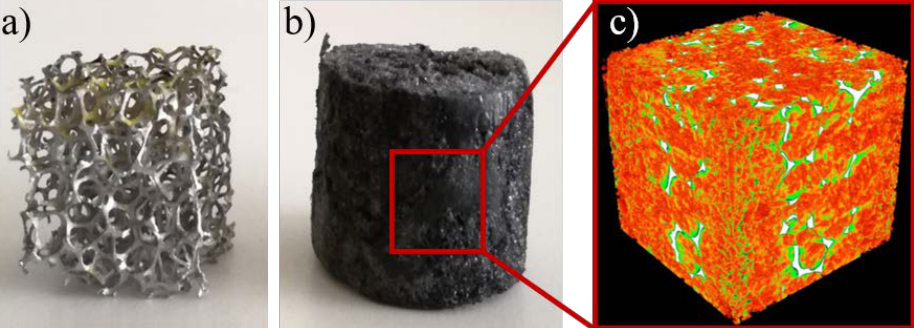
Figure 5. Specimens ( a ) Al-OC; ( b ) PUF/GNPs2.5-OC; and ( c ) µCT PUF/GNPs2.5-OC.